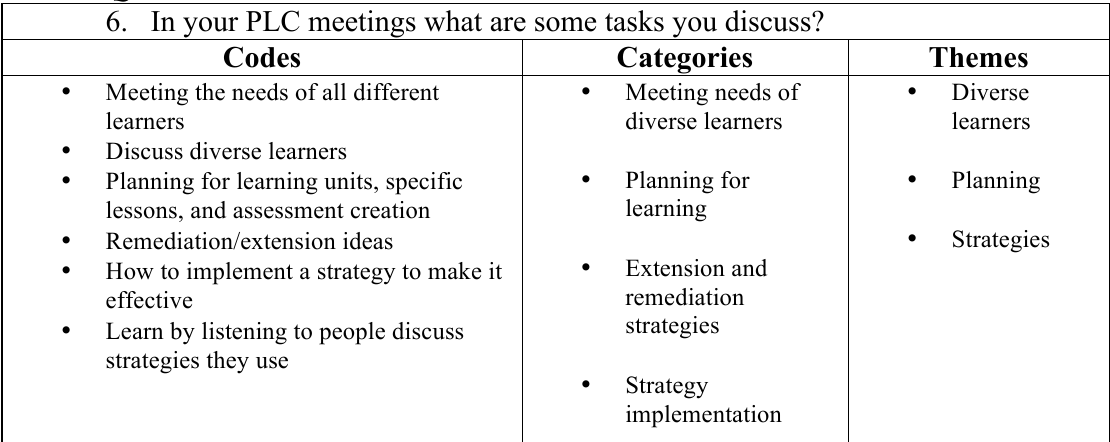
Teacher Question Six and